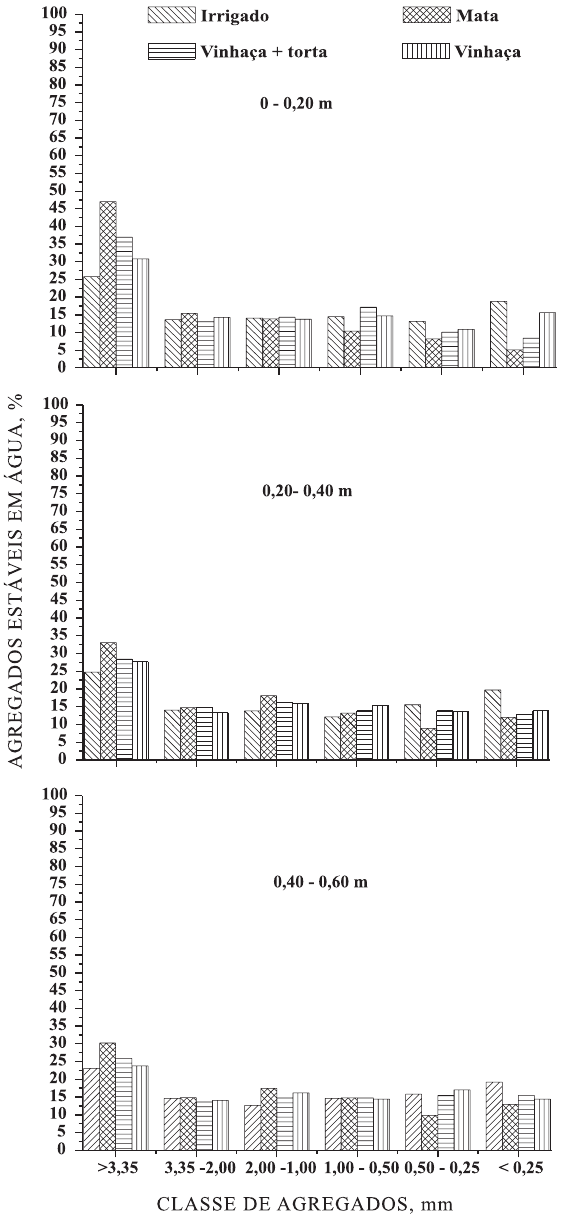
Figura 1. Distribuição dos agregados por peneira- mento por via úmida, nos sistemas de manejo e profundidades